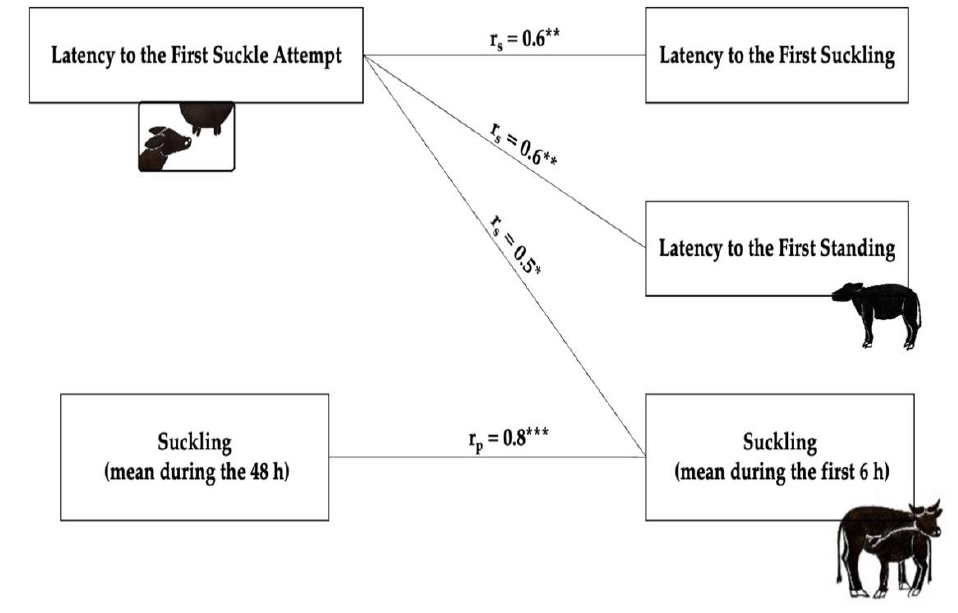
Figure 2. Correlations between different calves’ behaviours. r s = Spearman’s correlation; r p = Pearson’s correlation. * p < 0.05; ** p < 0.01; *** p < 0.001